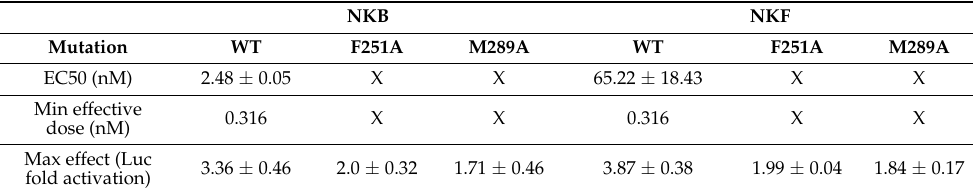
Table 5. Dose response in vitro analysis.